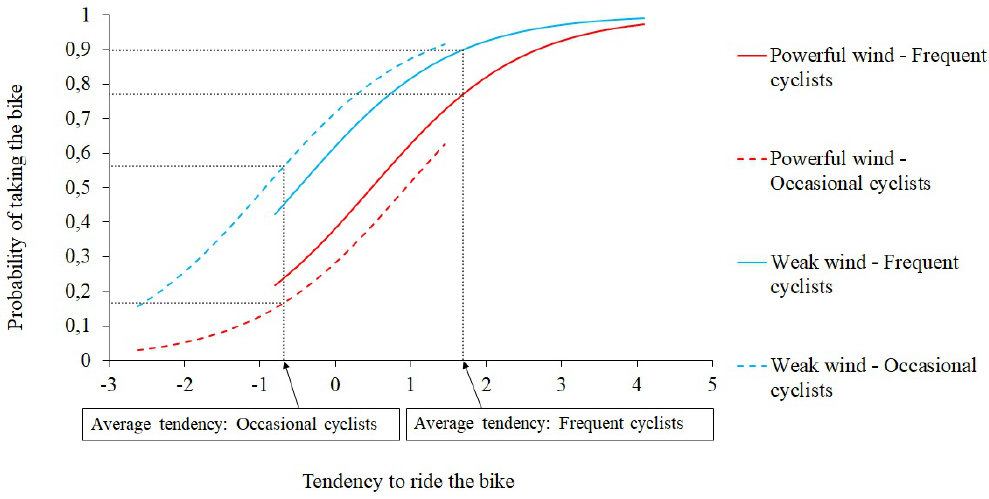
Figure 10. Probability of taking the bike for different levels of